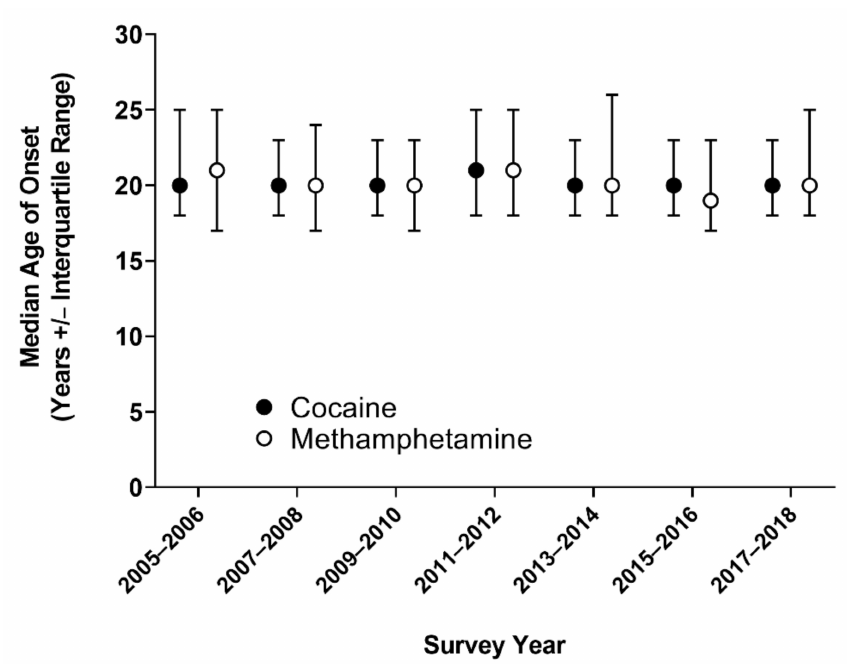
Figure 2. Median age (and interquartile range) of onset of cocaine and methamphetamine use by survey years, NHANES